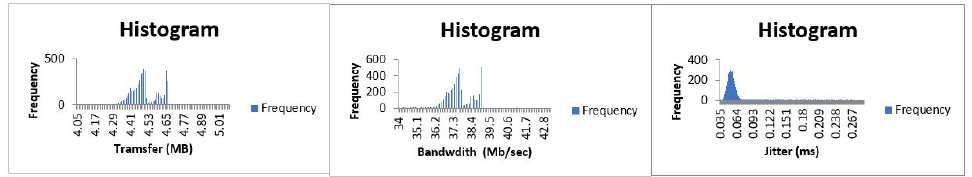
Figure 14. Node 1 with low data size utilized bandwidth and jitters.